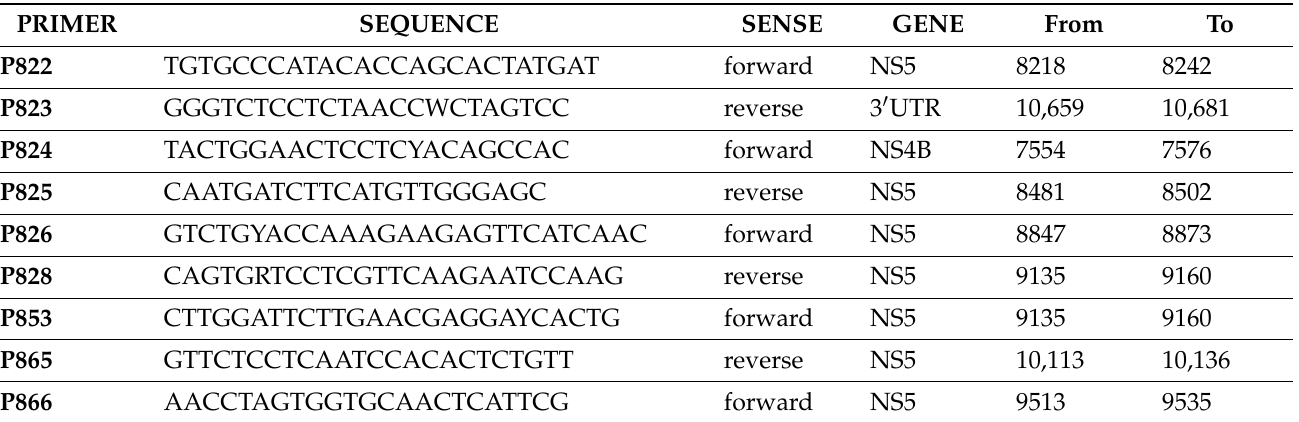
Table 4. Primer used to sequence the whole NS5 region. Coordinates are indicated on H/PF/2013 ZIKV strain (Gen Bank Accession Number